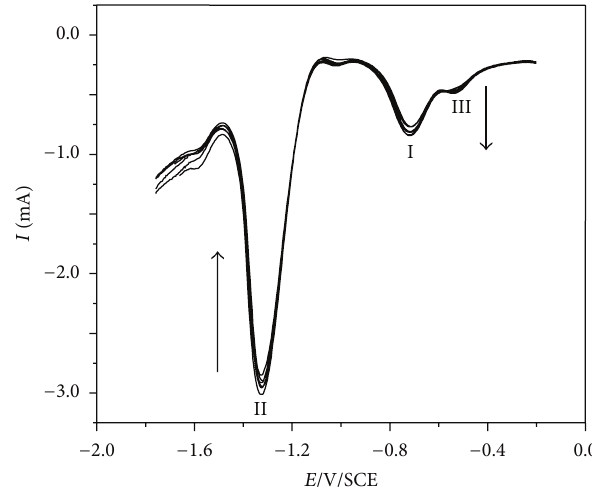
Figure 6: Consecutive net SWV voltammograms recorded with a thinfilm electrode in contact with aqueous medium at pH = 1. The other conditions are the same as for Figure